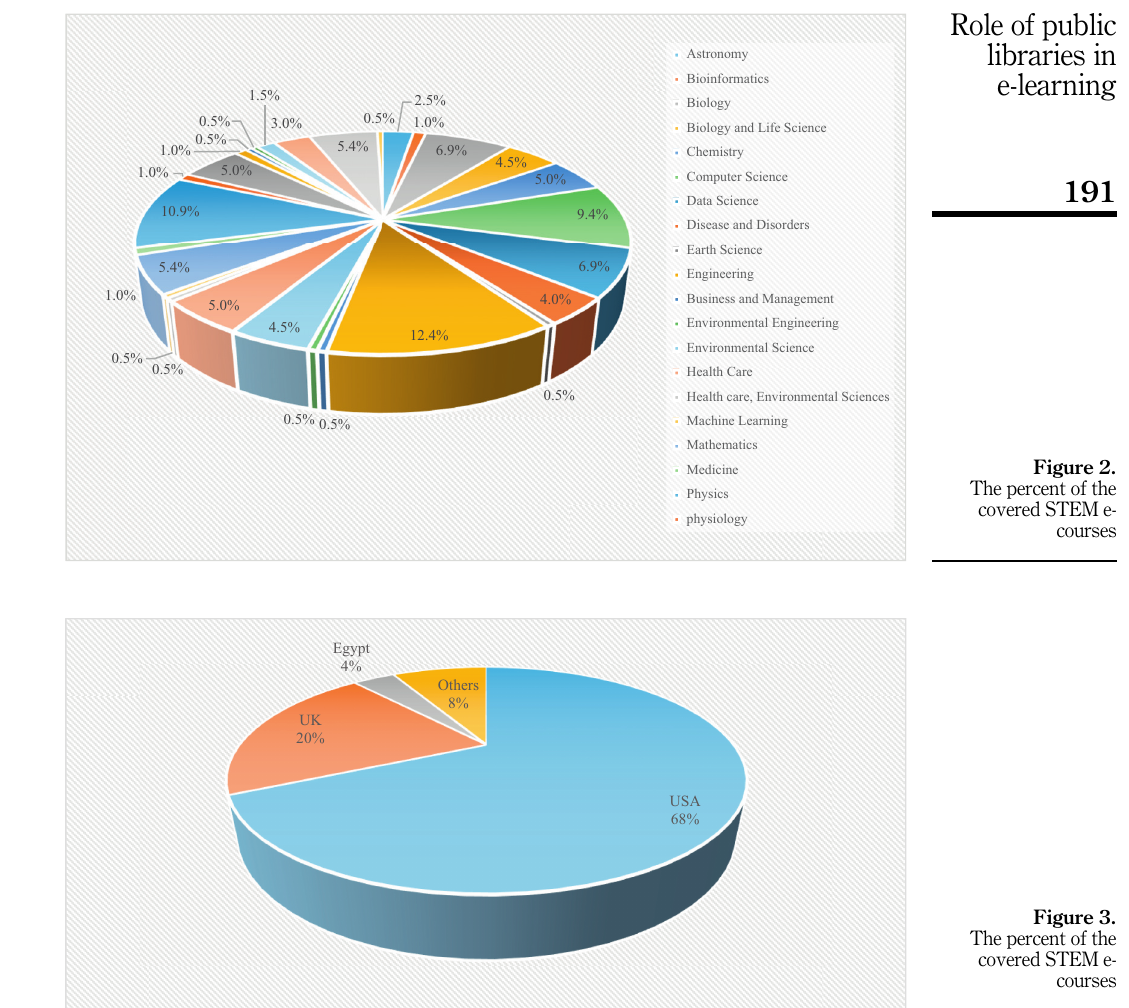
Figure 3. The percent of the covered STEM e-